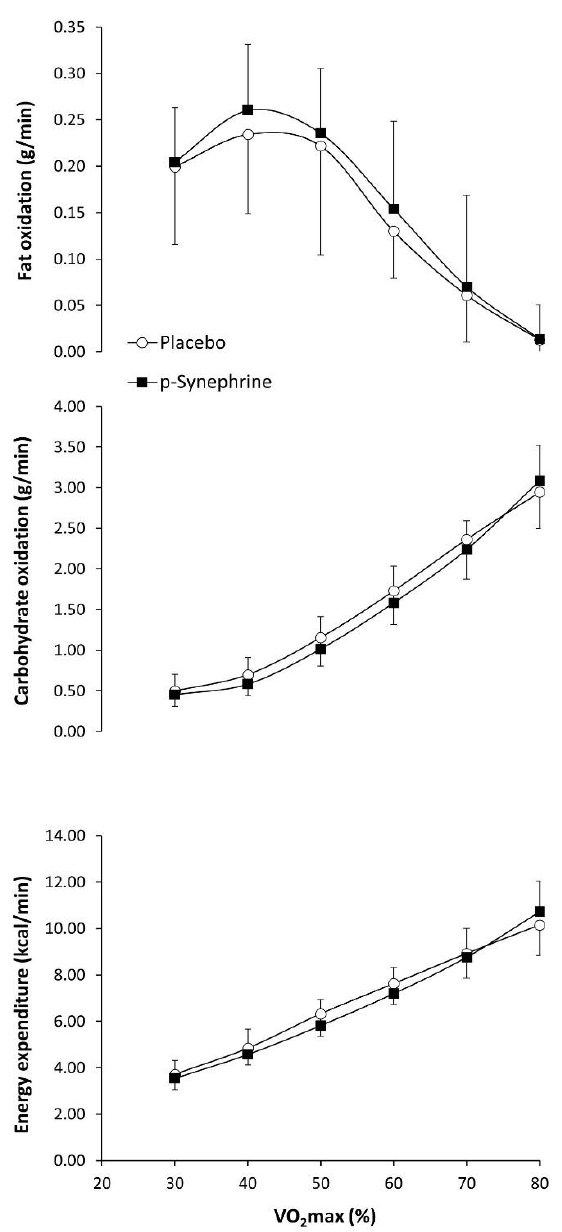
Figure 1. Fat oxidation, carbohydrate oxidation and energy expenditure during exercise of increasing intensity after the ingestion of 3 mg/kg of p -synephrine or a placebo in healthy active women. Figure 3 shows the effect of p -synephrine on MFO and Fatmax. The intake of p -synephrine did not modify MFO (0.28 ± 0.08 vs. 0.26 ± 0.10 g/min, p = 0.449, d = 0.21, respectively) or Fatmax (44.6 ± 7.8 vs. 40.8 ± 8.6%, p = 0.096, d = 0.50, respectively) over the placebo condition. Within 24 h of p -synephrine ingestion, participants reported higher ratings of irritabil- ity and gastrointestinal distress in comparison to the placebo (Table 3; p < 0.050). There were no other statistically significant differences in the magnitude of the remaining side effects between p -synephrine and placebo